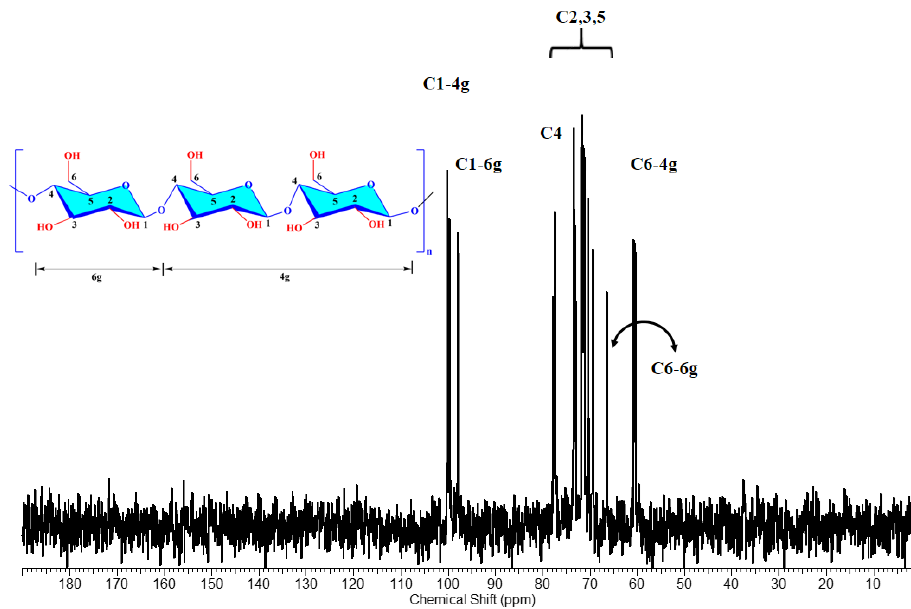
Materials 2022 , 15 , x FOR PEER REVIEW Figure 8. 13 C-NMR spectrum of pullulan (P). Figure 8. 13 C-NMR spectrum of pullulan (P).